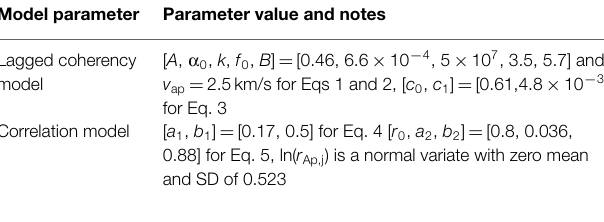
TABLE 1 | Typical model parameters for spatial correlation and coherency models based on Hong and Liu (2014). Model parameter Parameter value and